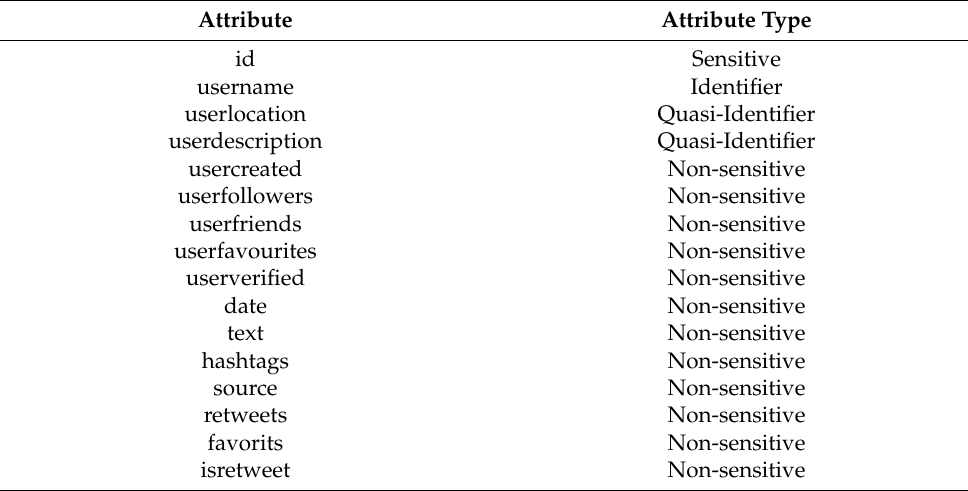
Table 5. Pfizer Vaccine Tweets Dataset Attribute